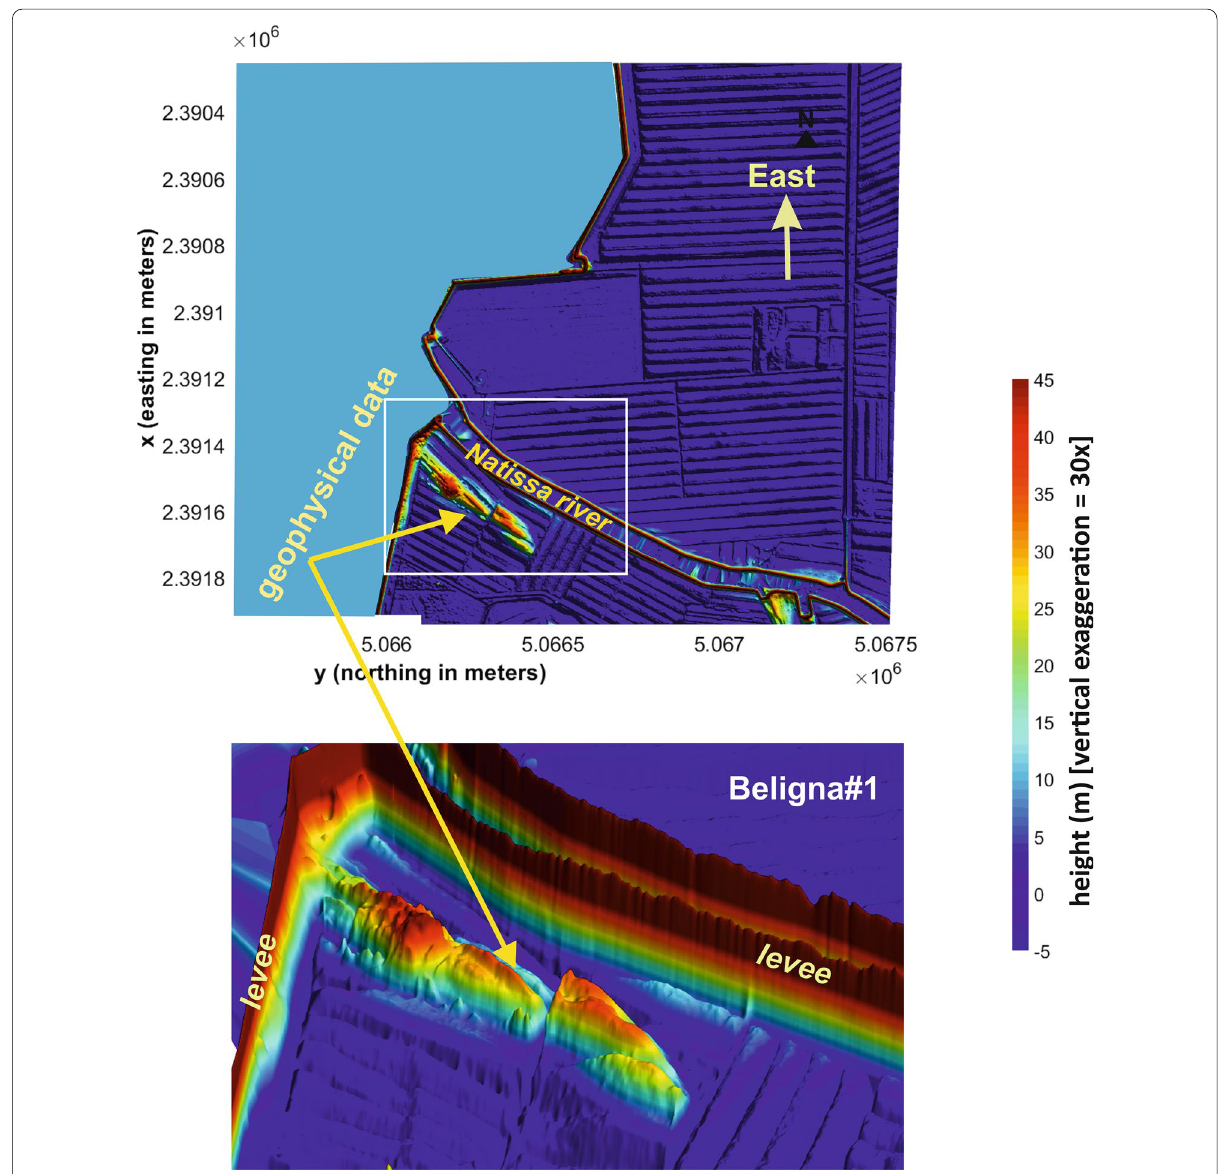
Fig. 3 Detailed DTM of the Beligna#1 area (vertical exaggeration 30x—the height of the residual dune is less than a couple of meters). Comprehensive geophysical data were acquired in the indicated